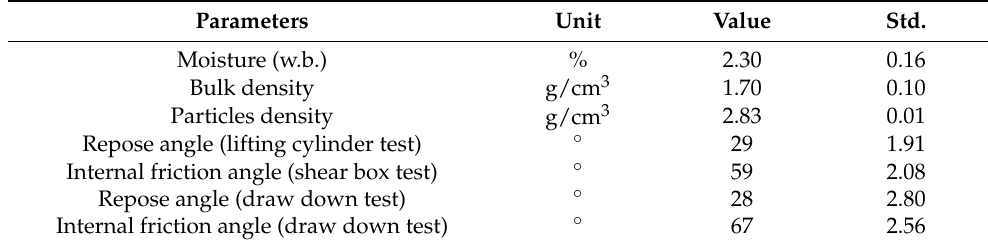
Table 3. Summary of Laboratory test results.